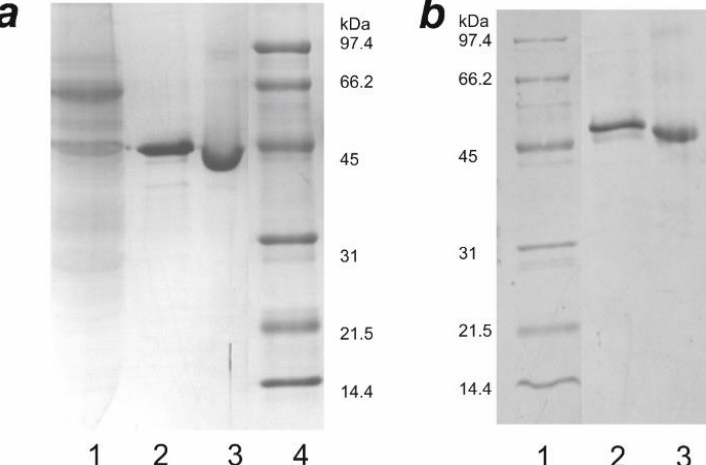
Figure A1. SDS-PAGE analysis of hybrid proteins’ purification from culture medium of insect cells. ( a ) Lanes correspond to 14D5a-MLuc7 samples: 1 – pellet after ammonium sulfate precipitation (30–65%, w/v); 2, 3 – protein samples after Ni-chromatography at denatured and semi-native conditions, respectively; 4 – protein standards (Bio-Rad). ( b ) Lanes correspond to MLuc7-14D5a